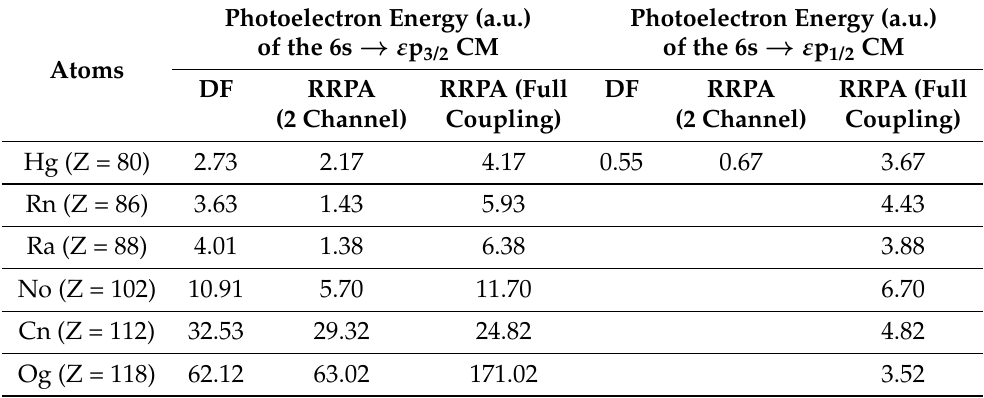
Table 1. Positions of the Cooper minima (CM) in Dirac–Fock (DF), two-channel RRPA and RRPA with full coupling in photoelectron energy in (a.u.) [5]. Photoelectron Energy Atoms